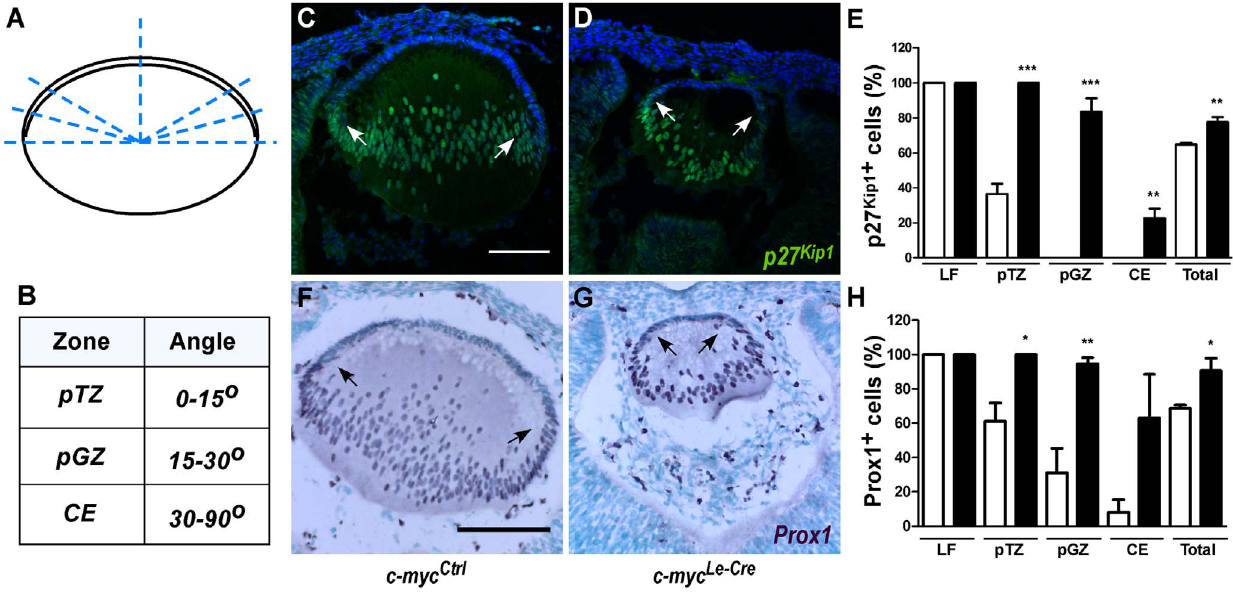
Figure 6. Misregulation of p27 Kip1 and Prox1 proteins in c-myc-deficient lens. ( A–B ) Schematic illustration of the division of the lens cells in 4 regions that were independently quantified in stained sections: central epithelia (CE), prospective germinative zone (pGZ), prospective transition zone (pTZ) and lens fibers (LF). ( C–D ) Immunofluorescence for p27 Kip1 and ( F–G ) immunohistochemistry for Prox1 were performed in control ( c- myc Ctrl ) and c-myc-deficient ( c-myc Le-Cre ) lens sections at E13.5 followed by nuclear either counterstaining with DAPI ( C–D ) or methylgreen ( F–G ), respectively. Proportions of p27 Kip1 immunopositive cells (white arrows) and Prox1 immunopositive cells (black arrows) were scored in each of the regions CE, GZ, TZ and LF ( c-myc Le-Cre ; n=3; c-myc Ctrl ; n=4). Inactivation of c-myc increased the proportion of cells expressing p27 Kip1 and Prox1 within lens tissue in vivo . Error bars indicate SEM; * p , 0, 05; ** p , 0, 01; *** p , 0, 001. Scale bar: 100 m m.